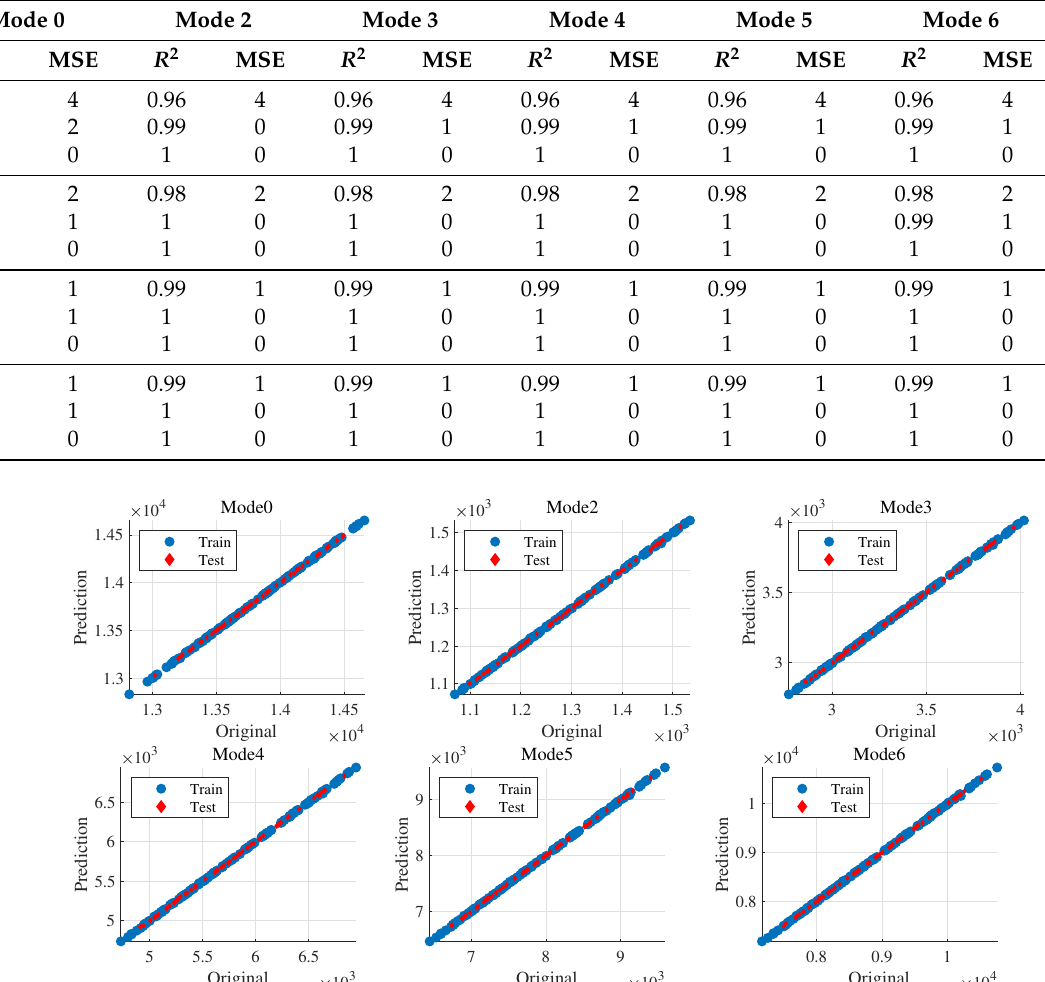
Table 5. Machine learning models performance to predict natural frequencies of mode-shapes